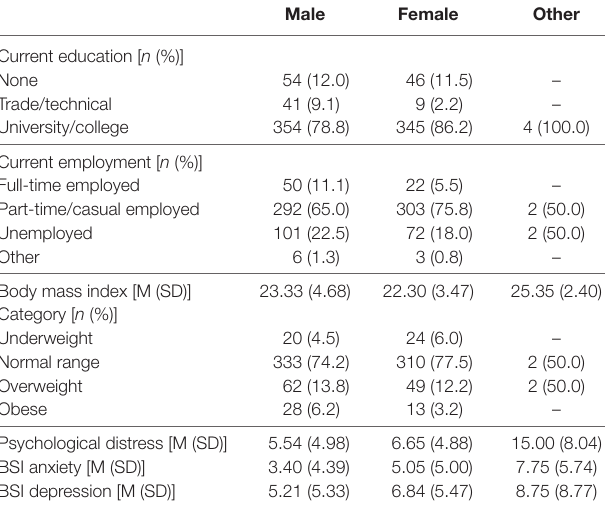
TaBle 2 | Sample characteristics ( n =